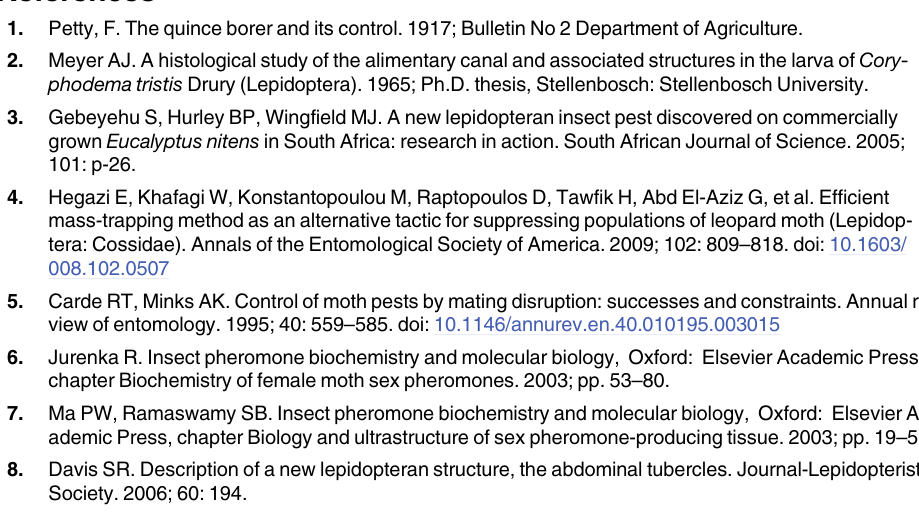
S4 Fig. Gravimetric pheromone release rate determination of pheromone permeation de- vices. Regression line slope values were used to estimate pheromone release rate. (TIF) S1 Table. Linear fit to dose response curve parameters for FID data for C. tristis males and females. (TIF) S2 Table. Linear fit to dose response curve parameters for EAD data for C. tristis males and females. (TIF) S3 Table. Chromatographic peak data of pheromone gland extract samples analyzed on the GC-MS. (TIF) S4 Table. Chromatographic peak data of pheromone gland extract samples analyzed on the GC (cid:3) GC-MS.